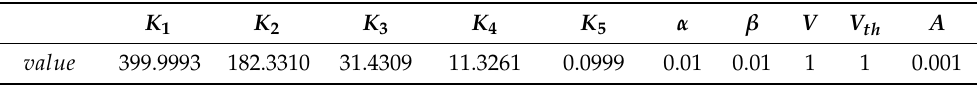
Figure 9. Experiment No. 2: Function IAE = f ( K 1 , K 2 , K 3 ) for gains limited to the value of 400 and α = 0.1, β = 0.01. Table 4. Parameters of the BELBIC altitude controller used in Experiment No.